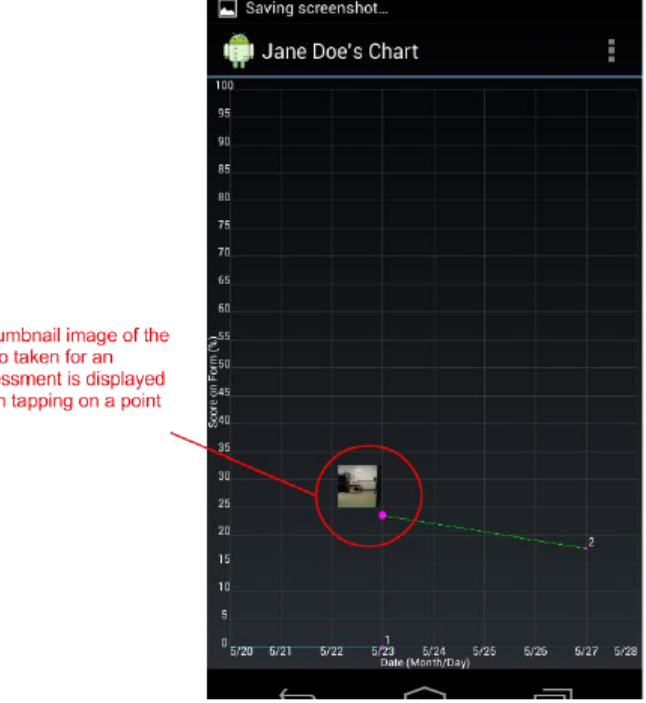
Figure 3. The Wound Graph screen plots all wound assessment scores on a graph. Tapping on line vertices (points) will display a thumbnail image of the photo taken for that assessment.